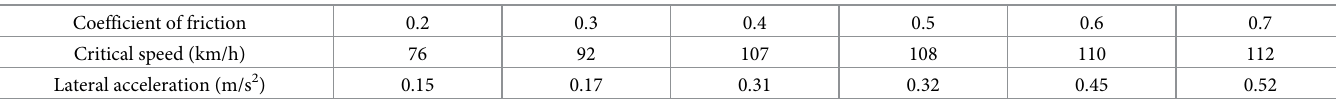
Table 3. Critical speed type with